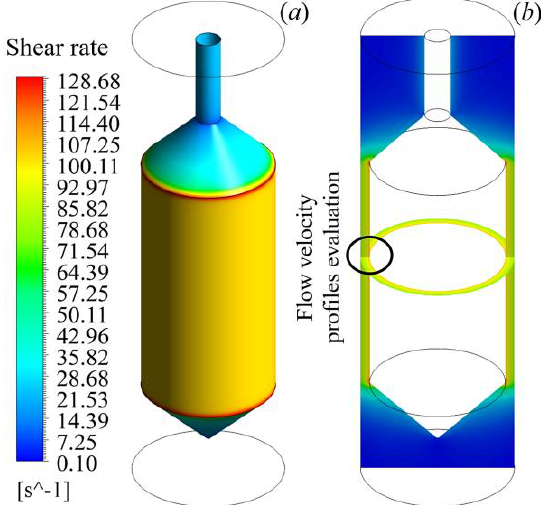
Fig. 10. The shear rate γ̇ contours on the spindle wall ( a ), in the XY and XZ plane ( b ).